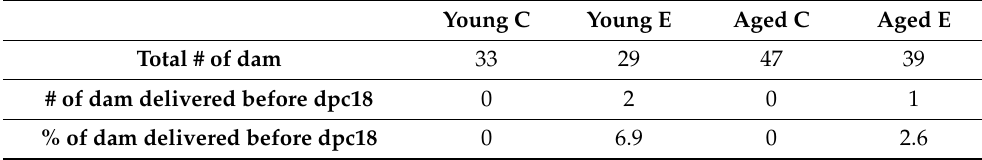
Table 1. Preterm labor.